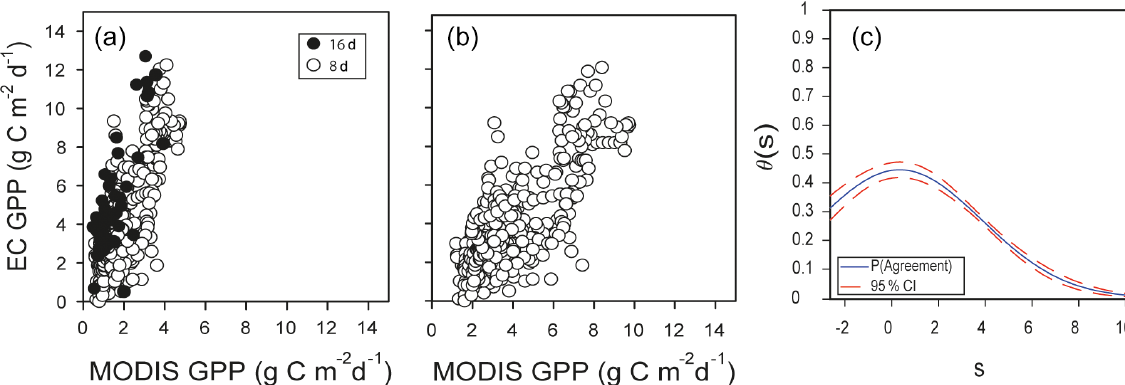
Figure 11. (a) MOD17 GPP daily time step from the Bernal site versus estimates of GPP from EC data using the complete dataset at a daily time step derived from spline for MOD17 GPP ( (cid:13) ), with r = 0 . 76, or 8d composite estimates obtained by 8d averages of EC GPP ( ◦ ), with r = 0 . 76. (b) Adjusted predictions of GPP from MODIS. (c) Corresponding function of probability of agreement for Fig. 7a using 1gCm − 2 d − 1 as a tolerable agreement between methods of estimation of GPP: EC data from the Bernal site and MODIS MOD17. The horizontal axis ( s ) represents the magnitude of the measurement. The vertical axis is the probability of agreement for the measurement.